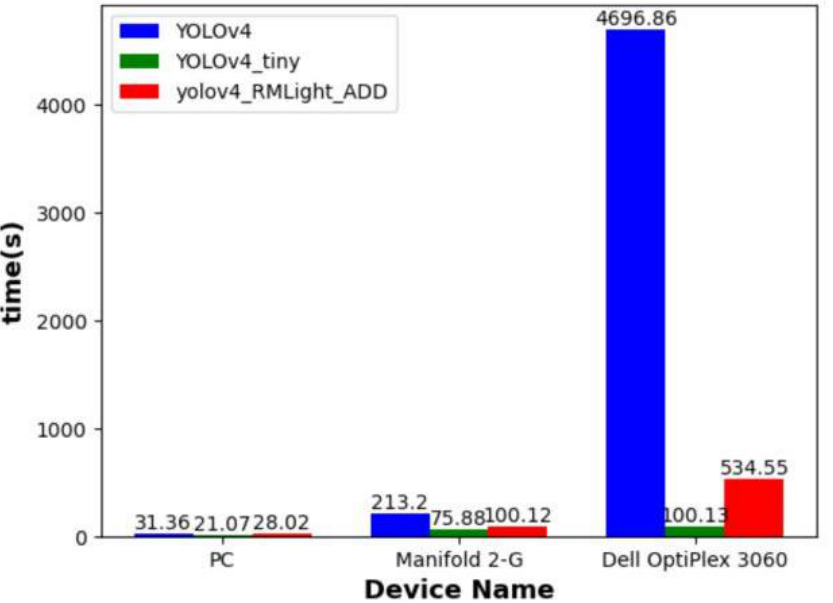
Figure 13. Time performance comparison. The vertical axis indicates the time taken to calculate the mAP value in seconds. The horizontal axis indicates the different devices.